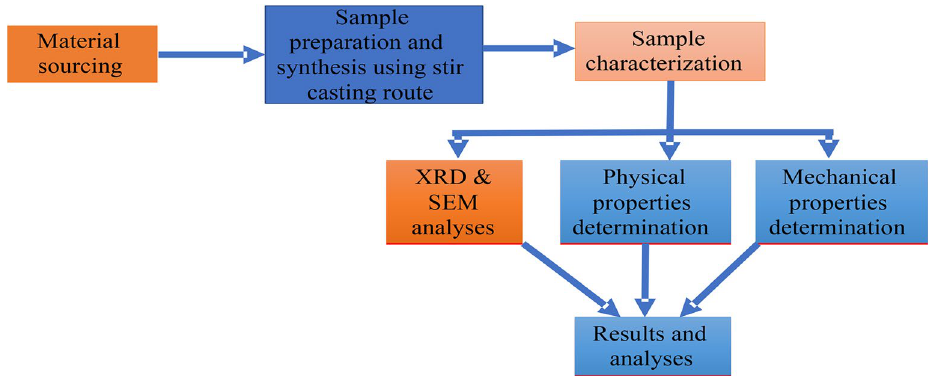
Figure 1. Experimental procedure schematic diagram.